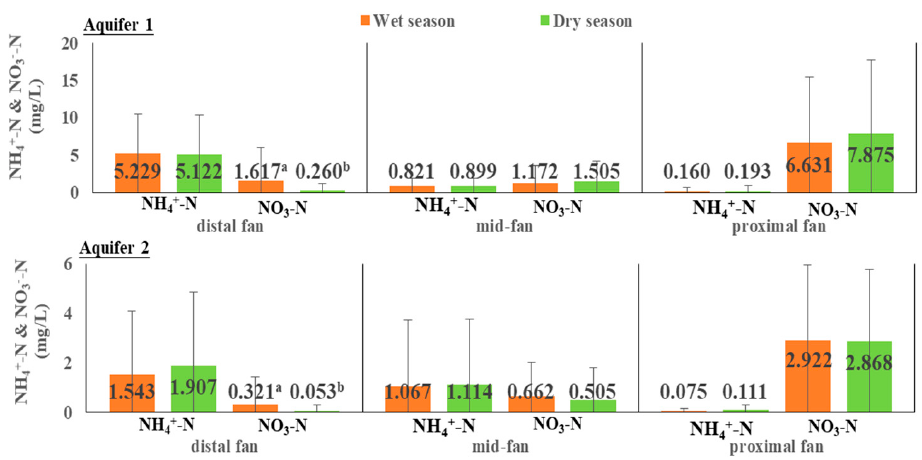
Figure 9. The mean concentration of NH 4+ -N and NO 3- -N, and statistical results of the proximal fan, mid-fan, and distal fan areas in both aquifers between wet and dry seasons. (a superscript character after the mean value means that the water quality parameter has significant differences)